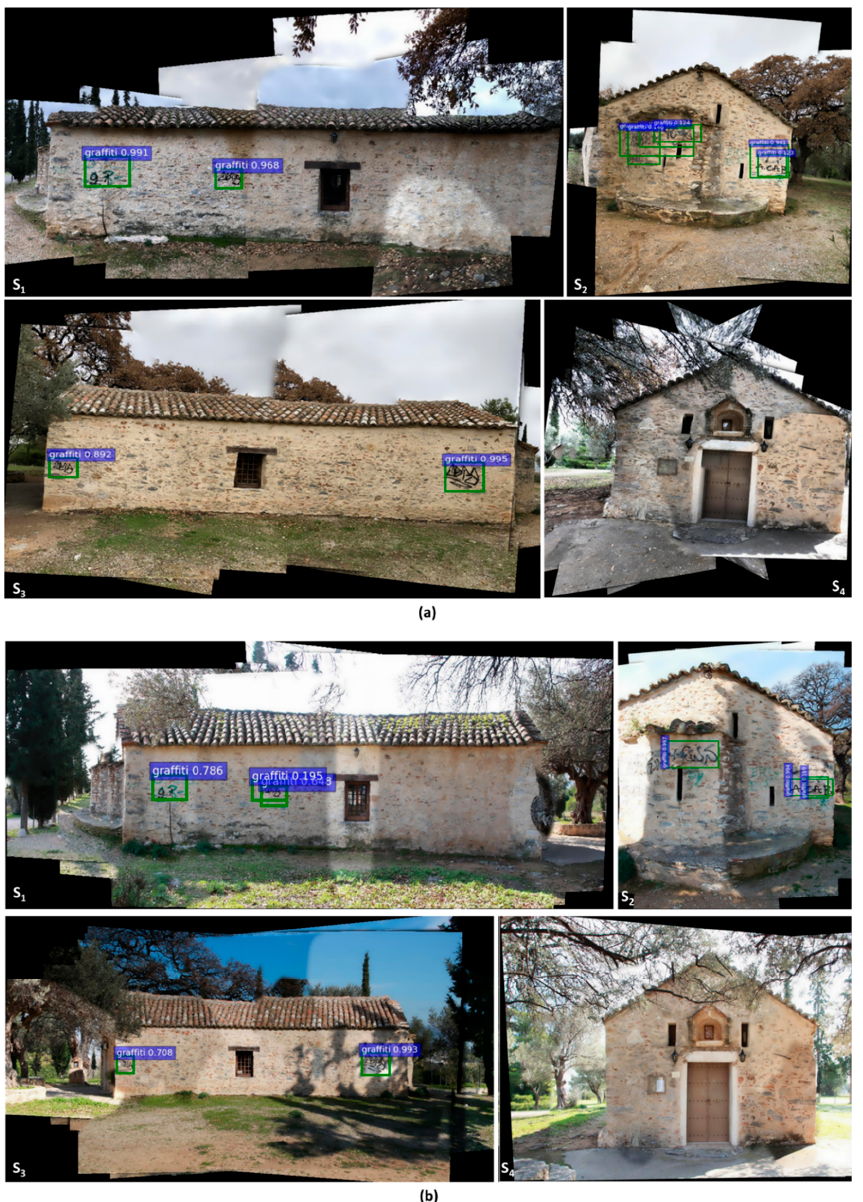
Figure 10. Graffiti-detection results from the orthophotos generated for the four façades of the Church of Agios Nikolaos based on data collected in ( a ) May 2018 and ( b ) January 2019.